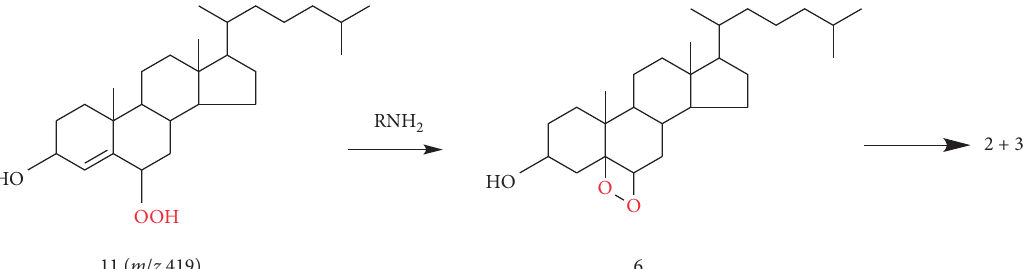
Scheme 3: Expected lysine-catalysed conversion of cholesterol-6-hydroperoxide 11 (this structure is general for both 6a- and 6b-hy- droperoxides) to secosterol aldehydes 2 and 3